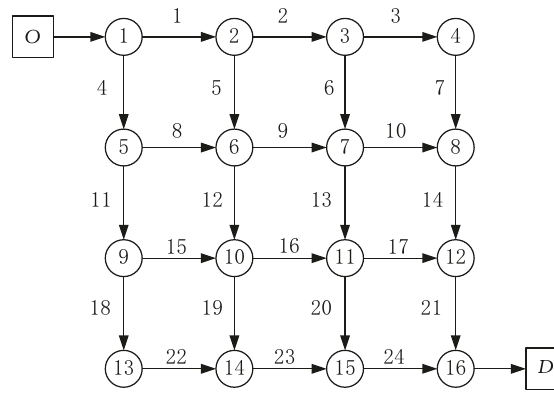
Figure 1: Sample of transportation